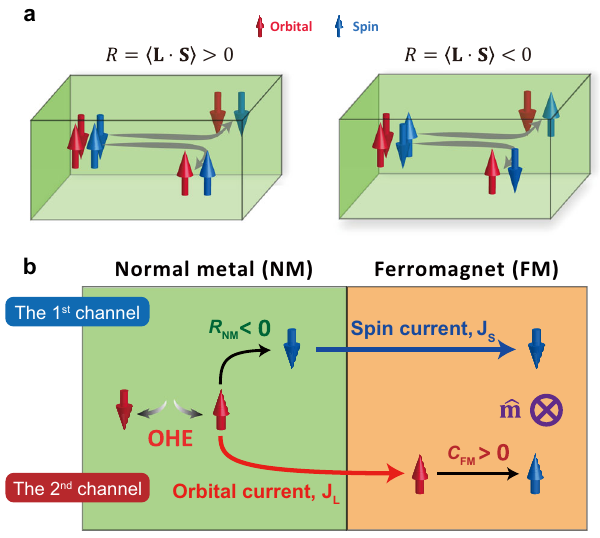
Fig. 1 Schematic Illustration of the OHE and orbital torque. a When an electric fi eld is applied along the horizontal direction, a transverse orbital current is generated owing to the OHE. This orbital current is converted to a spin current through the spin-orbit coupling. Depending on the sign of spin-orbit correlation R ¼ L (cid:2) S h i , the spin polarization of the resulting spin current is either parallel (left panel) or antiparallel (right panel) to the orbital polarization of the orbital current. b Two channels for generating the torque in FM/NM bilayers. The fi rst channel: An orbital current J L created through the OHE is converted to a spin current J S within the NM. For a negative spin-orbit correlation of NM ( R < 0), the direction of spin NM polarization carried by J S is the opposite to that of the orbital polarization carried by J L , which is the case of Ta. This spin current is injected into a FM and exerts a torque on the magnetization ^ m . The second channel: J L created through the OHE in the NM is injected into a FM in which J L is converted to ^ m , which we call the orbital torque. For FMs J J S . This S exerts a torque on with a positive orbital-to-spin conversion ef fi ciency of FM C FM (such as Fe, Co, CoFe, and Ni), the direction of the spin polarization carried by J S is the same with that of the orbital polarization carried by J L . When the second channel supplies a stronger torque than the fi rst channel and the contributions from the two channels have the opposite signs, the sign of the net torque is the opposite to that expected for the spin Hall effect of